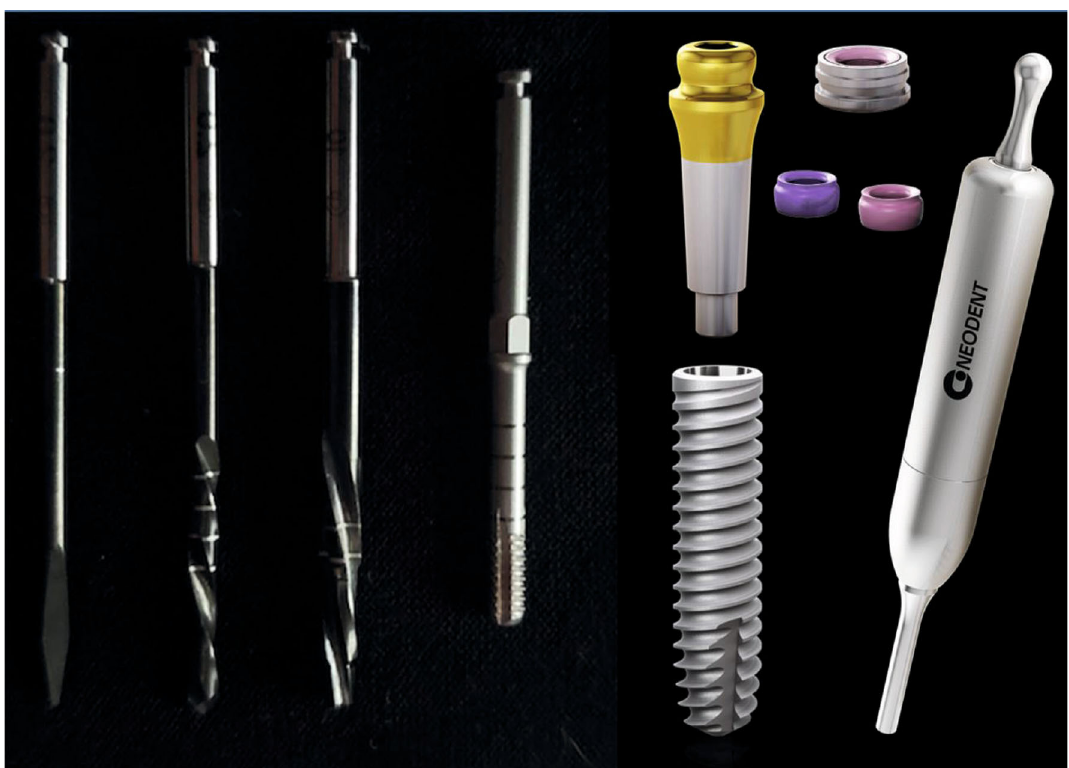
Figure 1: The Facility-Equator system. Sequence of drills used for installing the narrow diameter implant (Facility Initial Drill, Facility Twist Drill 2.0, Facility Drill 10, Facility); Facility implant (Ø 2 : 9mm × 10,12,14 mm ); Facility-Equator attachment, Equator O-ring with Cylinder, Equator O-ring (pink: less retention; purple: more retention), and Facility Abutment Placement